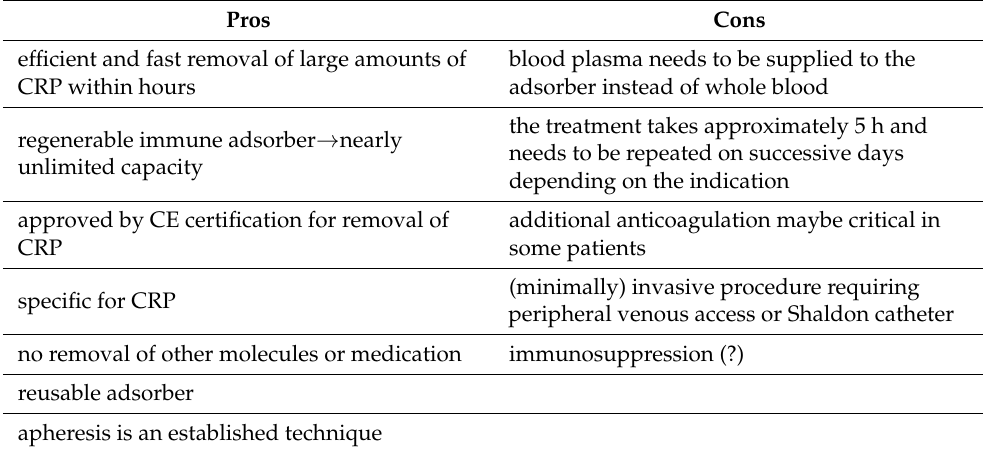
Table 1. Pros and cons for CRP